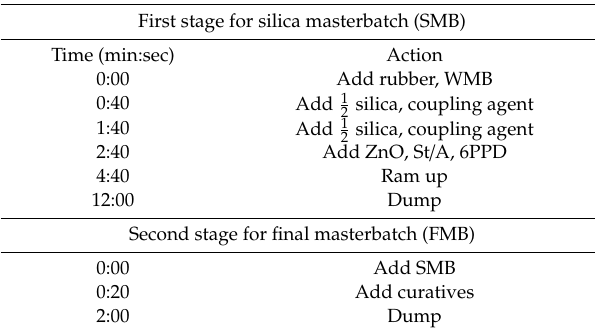
Table 3. Mixing procedures of SMB and